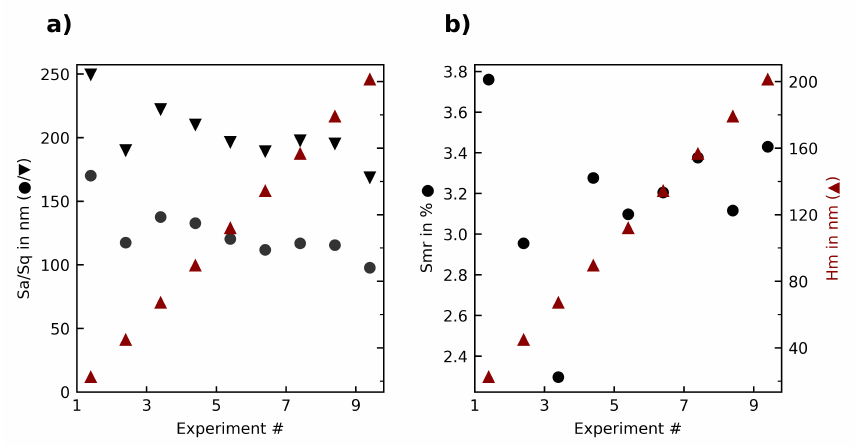
Figure 11. Overview of the ( a ) roughness parameters Sa, Sq; ( b ) surface bearing parameter Smr in relation to the median chip thickness Hm in the second experiment series.